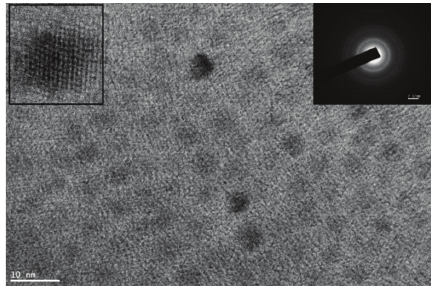
Figure 5: HRTEM image of NAC-capped CdSe QDs reacted for 65 min. The inset shows the HRTEM image of a single CdSe quantum dot (left) and electron diffraction (SAED) pattern (right).